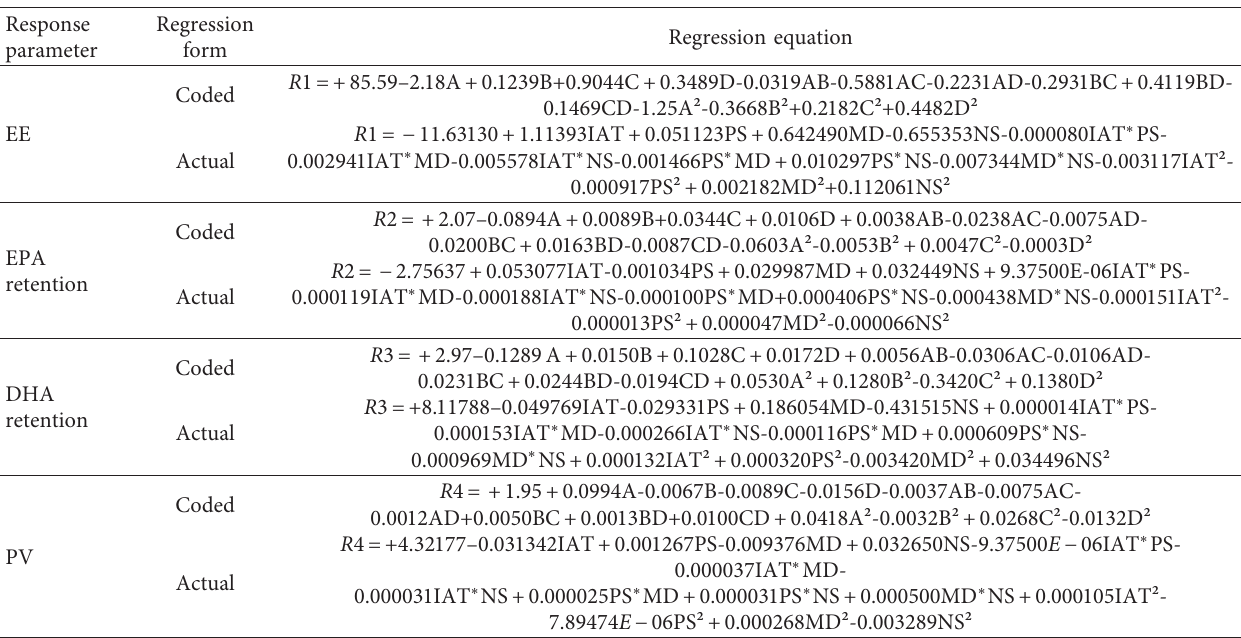
Table 5: Coded and actual regression equations for response parameters after spray drying